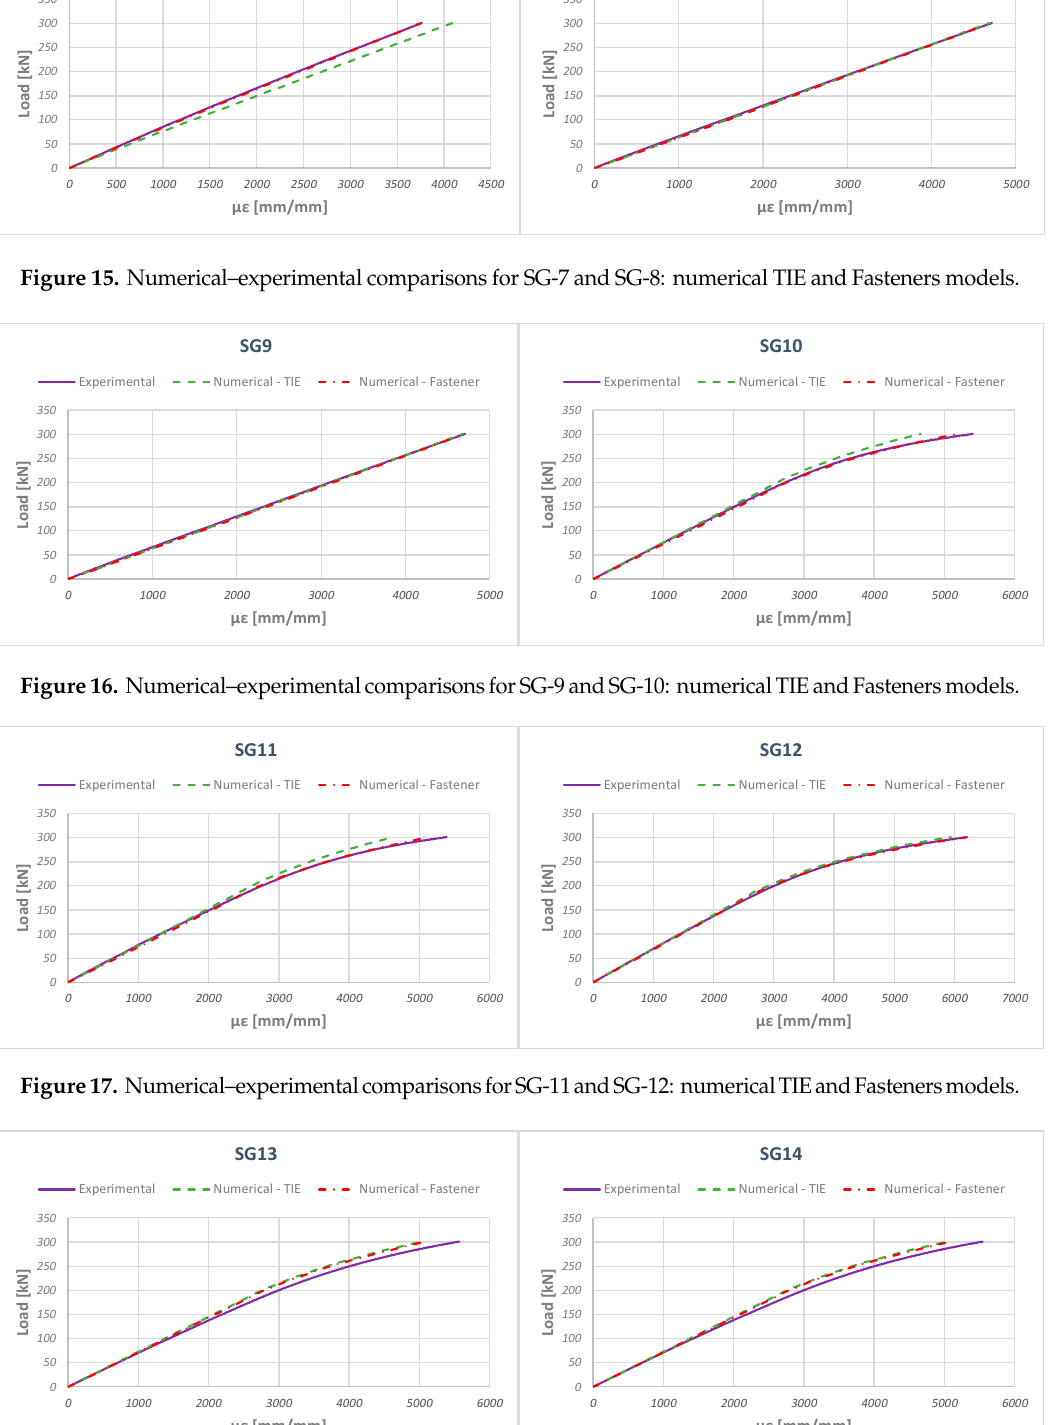
Figure 18. Numerical–experimental comparisons for SG-13 and SG-14: numerical TIE and Fasteners models.